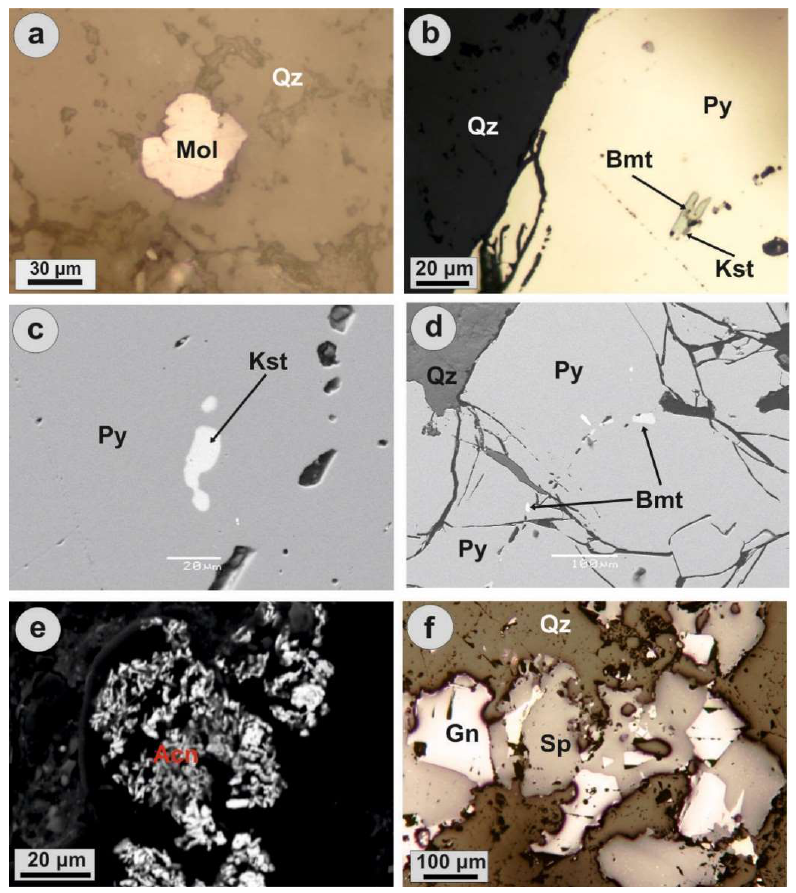
Figure 6. Reflected light microphotographs (plain polarized light, a , b and f ) and back-scattered electron images ( c , d and e ) of the metallic minerals assemblages from the Aisymi-Leptokarya prospect. ( a ) Molybdenite (Mol) included in quartz (Qz) (Sample EG10, potassic-altered microgranite porphyry); ( b ) Kesterite (Kst) and bismuthinite (Bmt) included in pyrite (Py) Sample EG3, potassic-altered microgranite porphyry; ( c ) Kesterite (Kst) and ( d ) bismuthinite (Bmt) included in pyrite (Py) (Sample EG3, potassic-altered microgranite porphyry); ( e ) Skeletal acanthite (Sample EG25; oxidized/phyllic-altered microgranite porphyry); ( f ) Galena (Gn) in association with sphalerite (Sp) (Sample EG1, base metal vein).